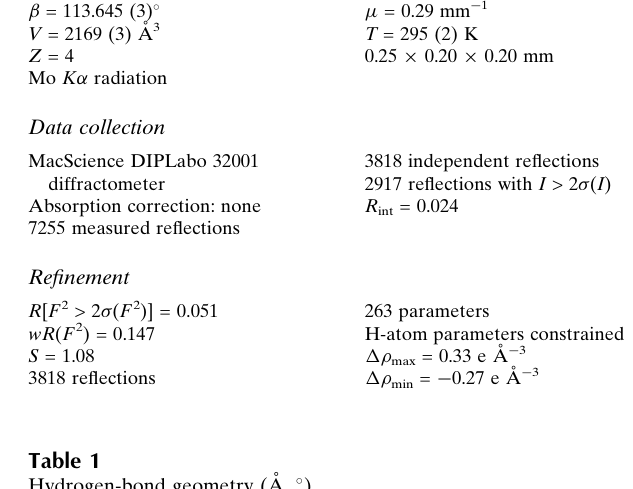
Hydrogen-bond geometry (A˚ , (cid:1)